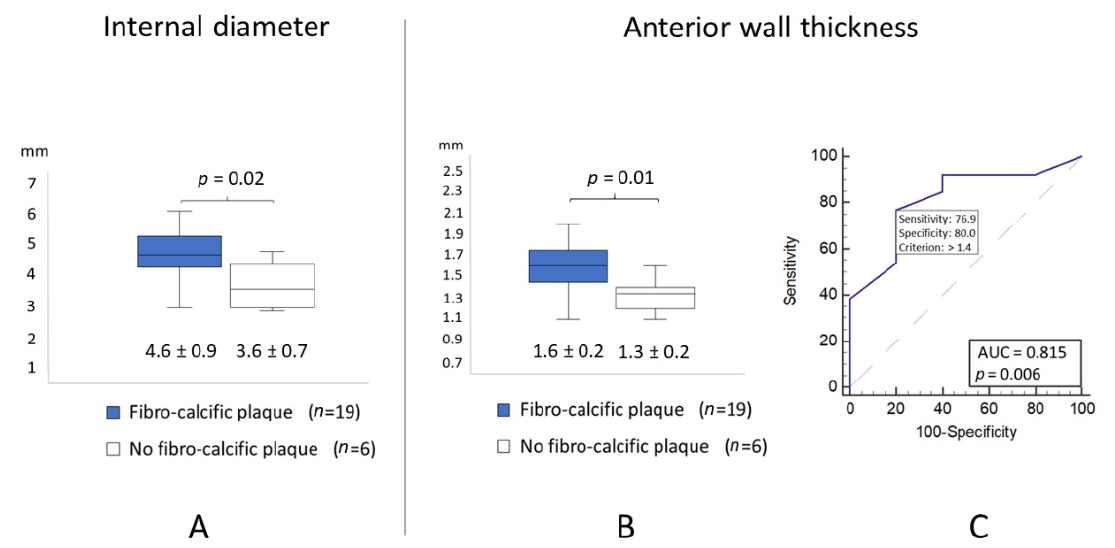
Figure 2. Correlation between anterior wall thickness and internal diameter of the LMCA measured by TTE. LMCA: left main coronary artery; TTE: trans thoracic echocardiogram. Echocardiographic measurements of the internal diameter and anterior wall thickness of the LMCA were significantly higher in patients with fibro-calcific plaques (Figure 3A,B). The diagnostic performance of wall thickness of the LMCA for the detection of fibro-calcific plaques is presented as an ROC curve (Figure 3C). A value > 1.4 mm was associated with fibro-calcific plaque (area under the curve: 0.815; p = 0.006), with the highest sensitivity and specificity of 76.9% and 80%, respectively, to predict fibro-calcific plaques of the LMCA. Youden’s Index was 0.56.